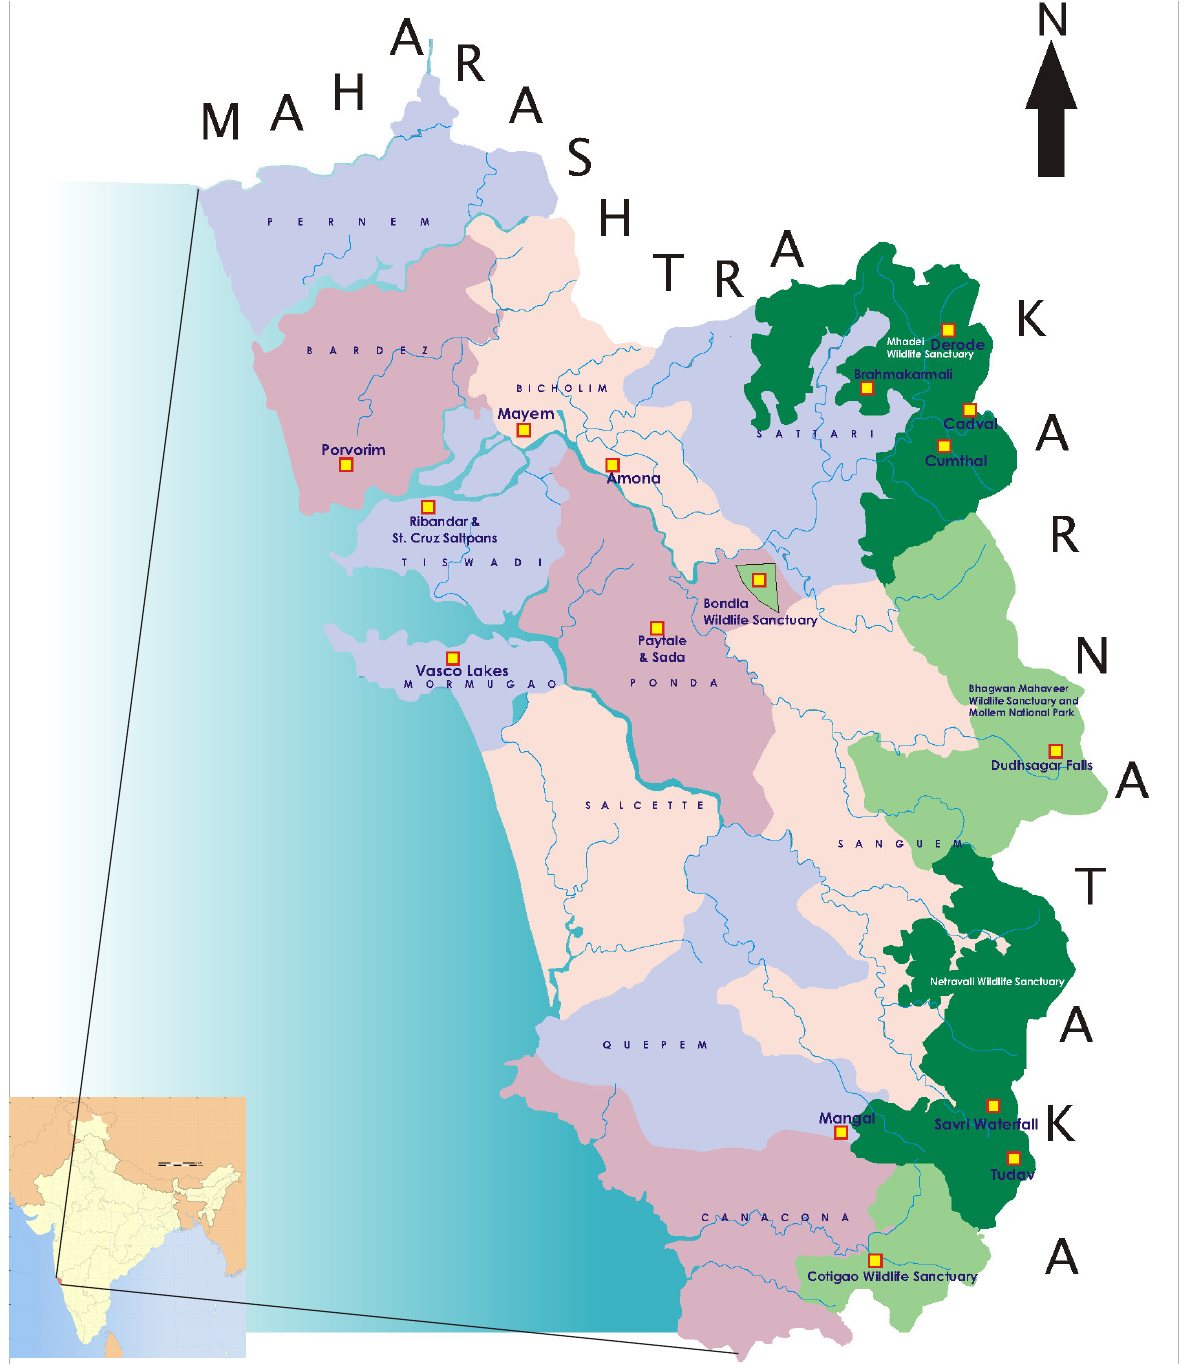
Image 1. The survey locations are marked on the state